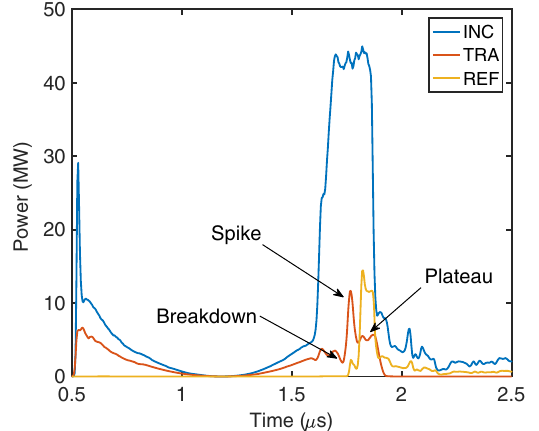
FIG. 8. Possible scenarios of rf power production after a breakdown at 10 cm after the entrance of the structure. The maximum rf production (red curve) is calculated adding the beam contribution to the unloaded profile starting at the breakdown location.